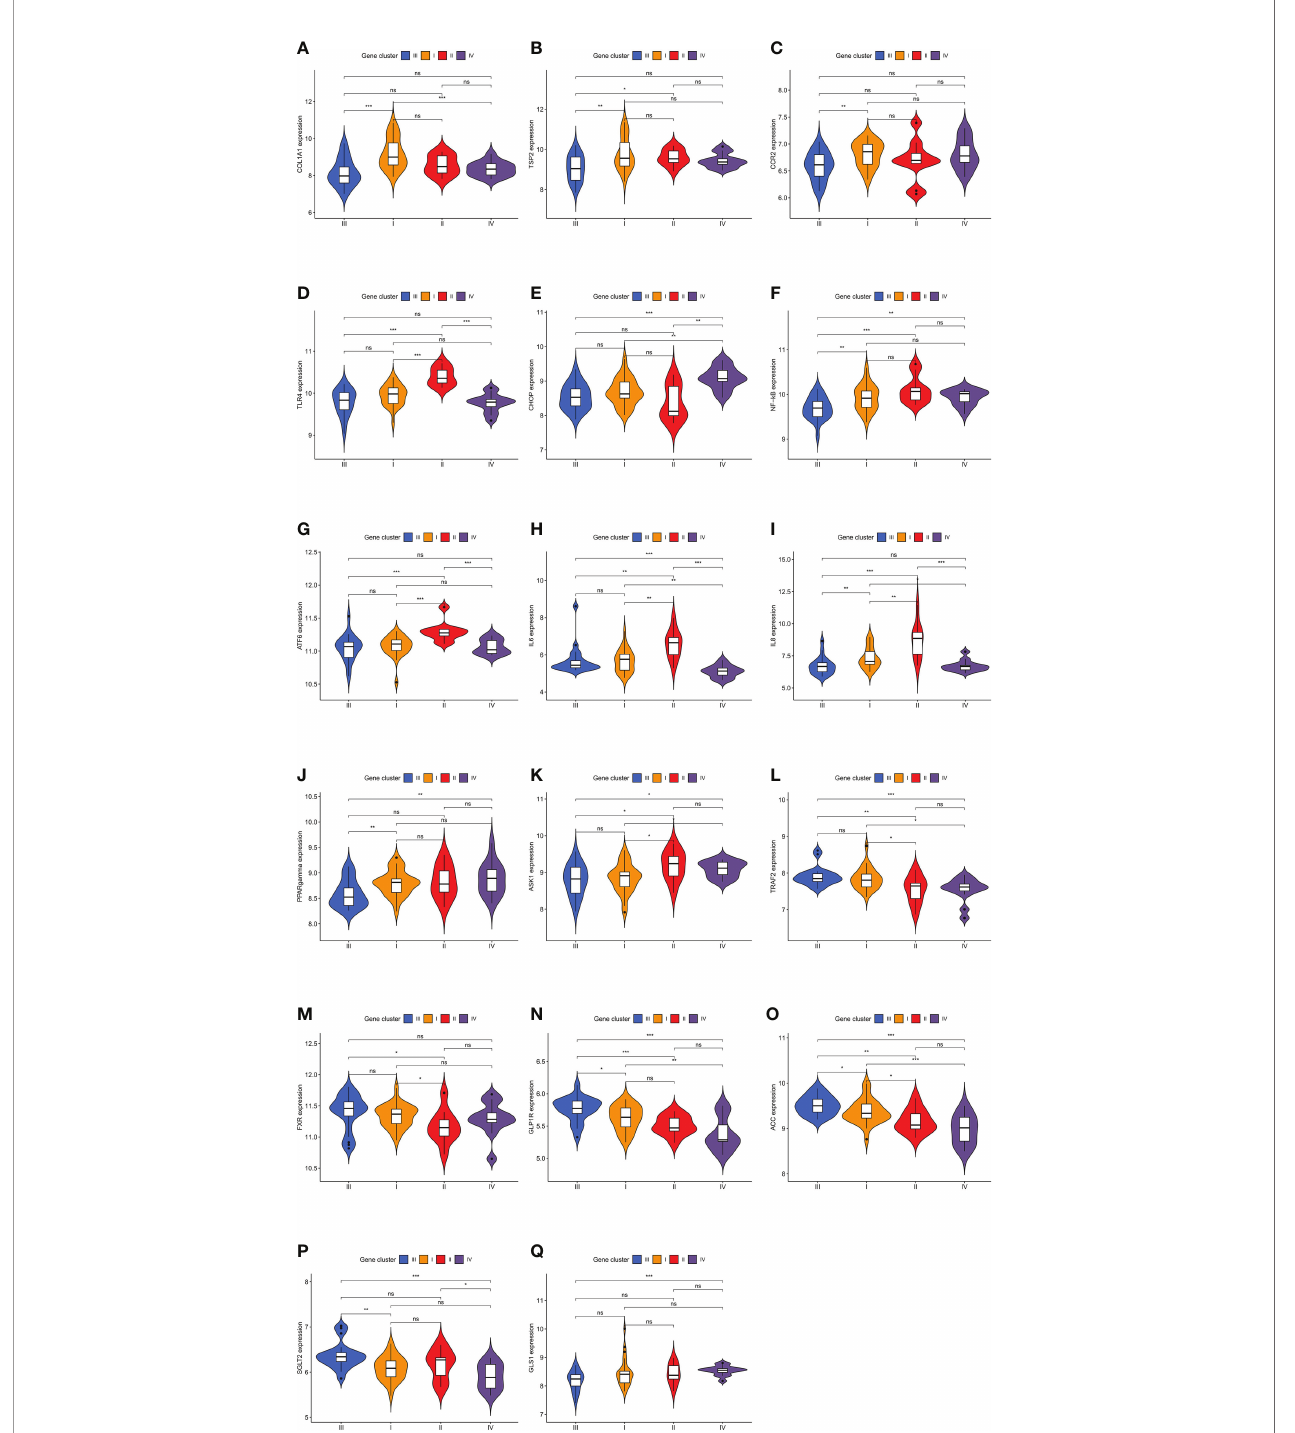
FIGURE 8 | Expression levels of characteristic genes in four different molecular subtypes. The comparisons of genes among the four molecular subtypes were conducted based on the Kruskal – Wallis test. (A) Difference in COL1A1 expression level. (B) Difference in TSP2 expression level. (C) Difference in CCR2 expression level. (D) Difference in TLR4 expression level. (E) Difference in CHOP expression level. (F) Difference in NF-kB expression level. (G) Difference in ATF6 expression level. (H) Difference in IL6 expression level. (I) Difference in IL8 expression level. (J) Difference in PPARgamma expression level. (K) Difference in ASK1 expression level. (L) Difference in TRAF2 expression level. (M) Difference in FXR expression level. (N) Difference in GLP1R expression level. (O) Difference in ACC expression level. (P) Difference in SGLT2 expression level. (Q) Difference in GLS1 expression level. (*P < 0.05; **P < 0.01; ***P < 0.001; ns, not signi fi